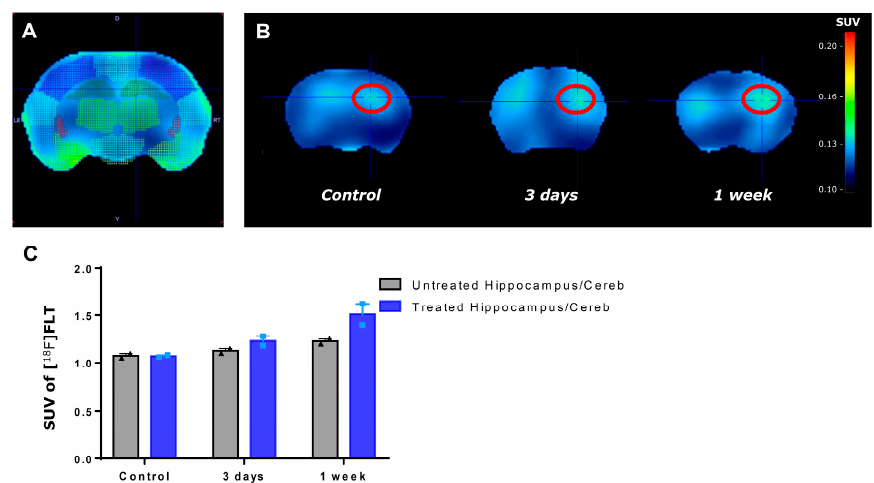
Figure 4. [ 18 F] FLT activation by using LIFUS. ( A ) Identification of the site using the rat brain atlas. ( B ) [ 18 F] FLT-PET was taken at 3 days and 1 week in the control and LIFUS groups. ( C ) Comparison of SUV between the untreated and treated hippocampus in each group. Cereb—cerebellum; FLT—fluoro-L-thymidine; SUV—standardized uptake value.